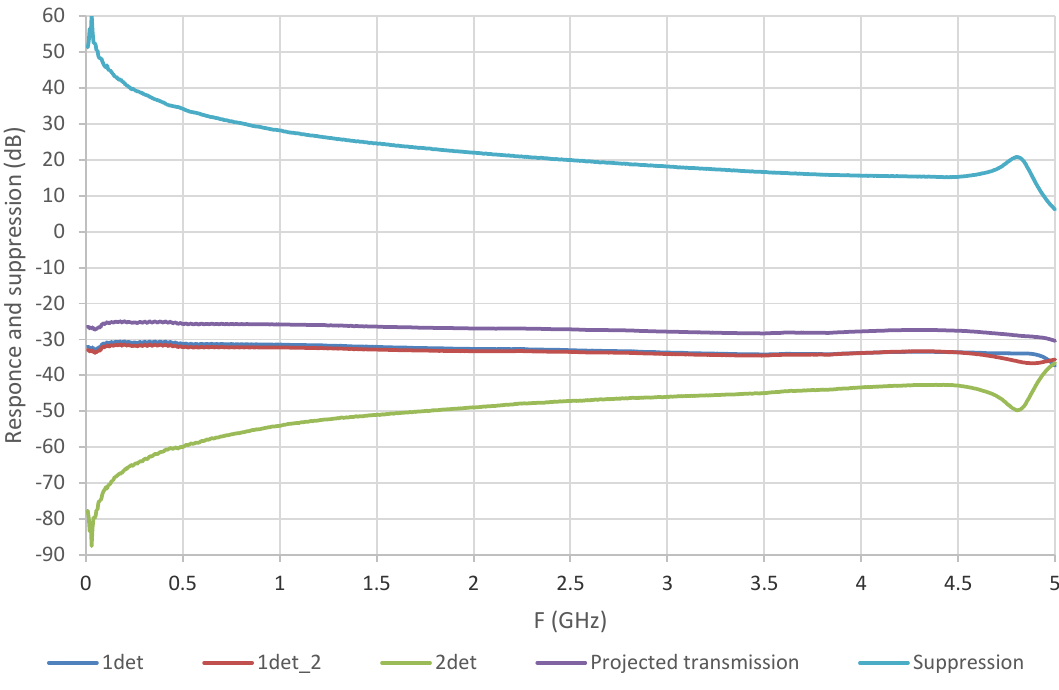
Figure 4. Scheme for demonstration of the common-mode noise suppression. ( a ) general scheme of the device, ( b ) photo of the device case, ( c ) Mach-Zehnder modulator in the system.